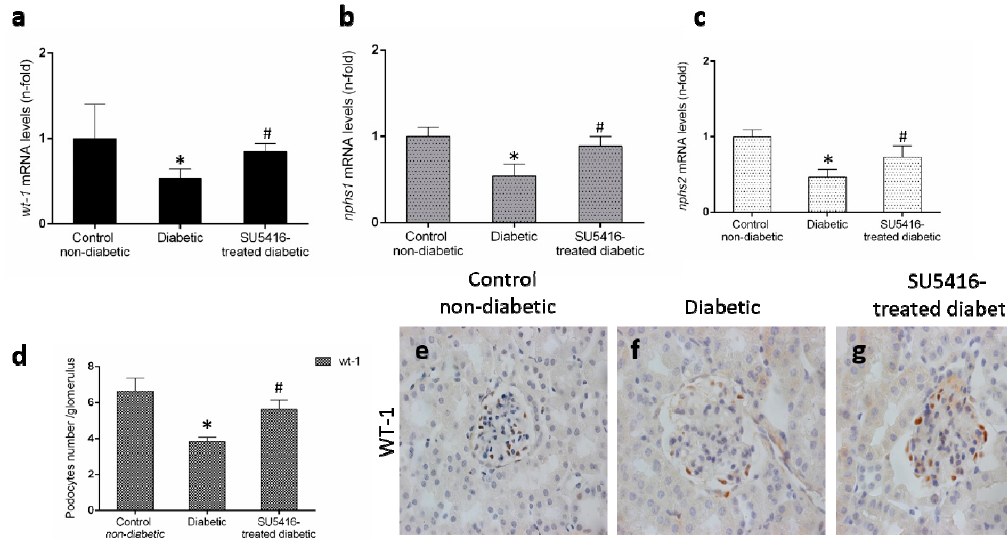
Figure 5. VEGFR2 kinase inhibition restores podocyte damage induced by experimental diabetes. Gene expression levels of ( a ) wt-1 , ( b ) nphs1 , and ( c ) nphs2 were evaluated by real-time polymerase chain reaction. mRNA levels in each sample were normalized by cyclophilin 1. Occurring at each time point, data were normalized by the mean value of their corresponding controls. ( d ) The average number of podocytes observed of a total of 25 glomeruli per animal, and the mean ± SEM of control non-diabetic mice, diabetic mice, and SU5416-treated diabetic groups. Representative images of immunohistochemistry against podocyte marker Wilms tumor protein 1 (WT-1; brown stained nuclei) for ( e ) control non-diabetic mice, ( f ) diabetic mice and ( g ) SU5416-treated diabetic mice. Magnification × 400. Bars = 20 µ m. * p < 0.05 versus control. Data as mean ± SEM of 6–8 mice per group. * p < 0.05 versus control non-diabetic, # p < 0.05 versus